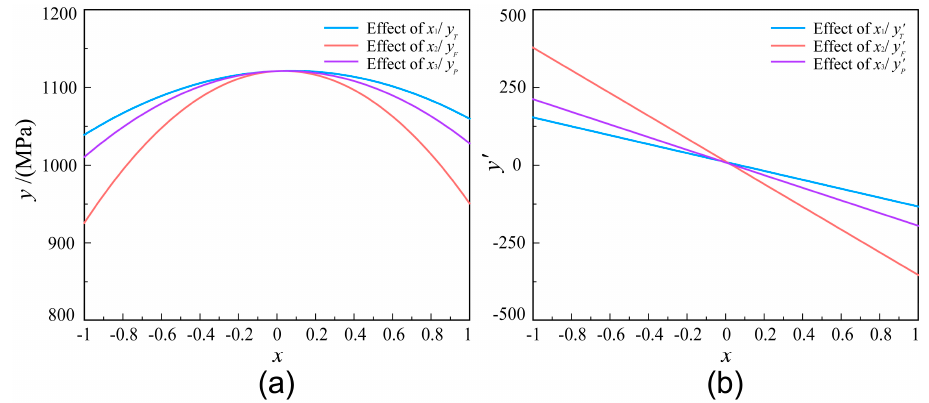
Figure 4. Effects of processing parameters. ( a ) The regression curve of sub-model; ( b ) The sensitivity model of each factor.